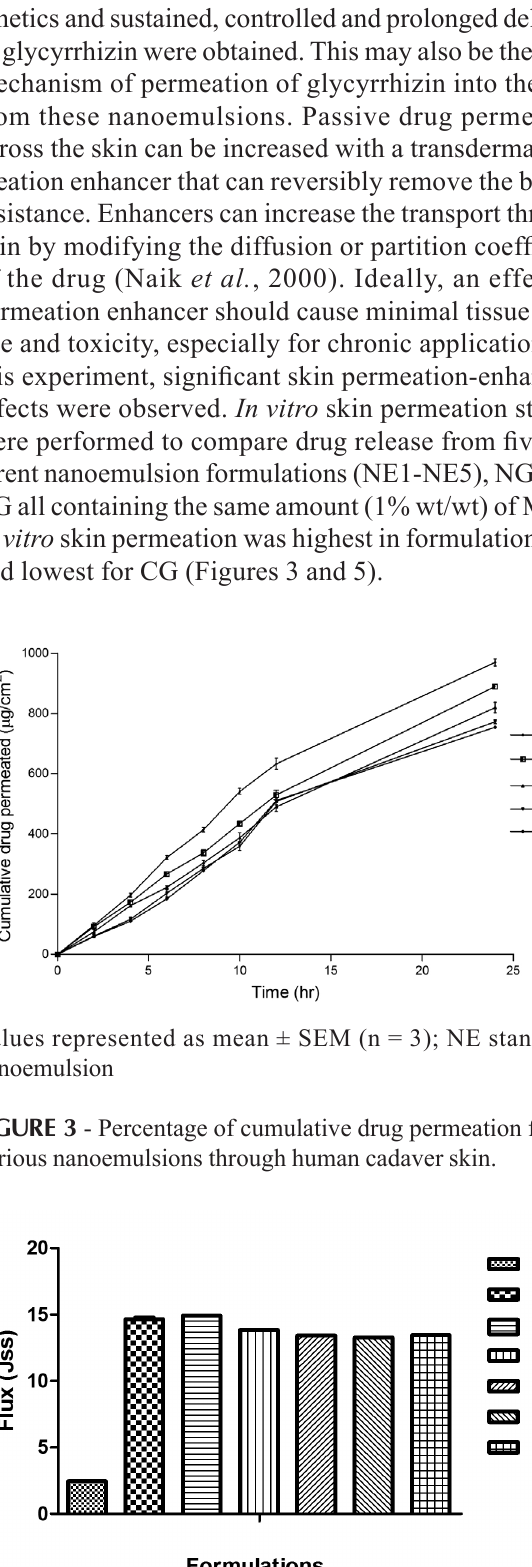
FIGURE 4 - Steady-state transdermal flux of glycyrrhizin across human cadaver